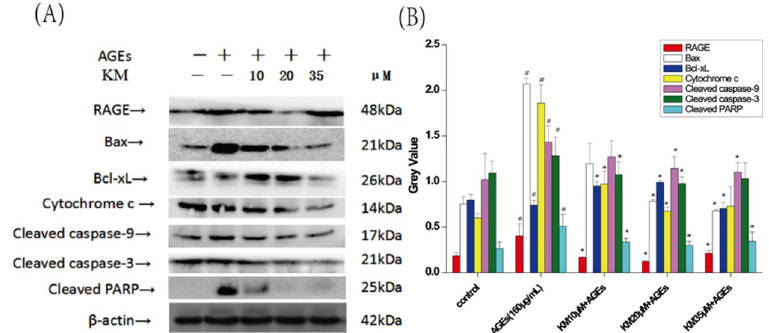
Figure 7. KM modulates the expression of both pro- and anti-apoptotic proteins in GMCs treated with AGEs. Effects of KM on AGE-induced apoptosis-related protein. GMCs were treated with AGEs (160 µ g/mL) and KM (10, 20, or 35 µ M). ( A ) The protein levels of RAGE, Bax, Bcl-xL and Cytochrome c, as well as the cleavage of caspases-9, -3 and poly-(ADP-ribose) polymerase (PARP), were examined by Western blot. + means adding reagents, − means not joining ( B ) The results were presented as mean ± SEM. * p < 0.05, vs. AGE group; # p < 0.05, vs. control group.